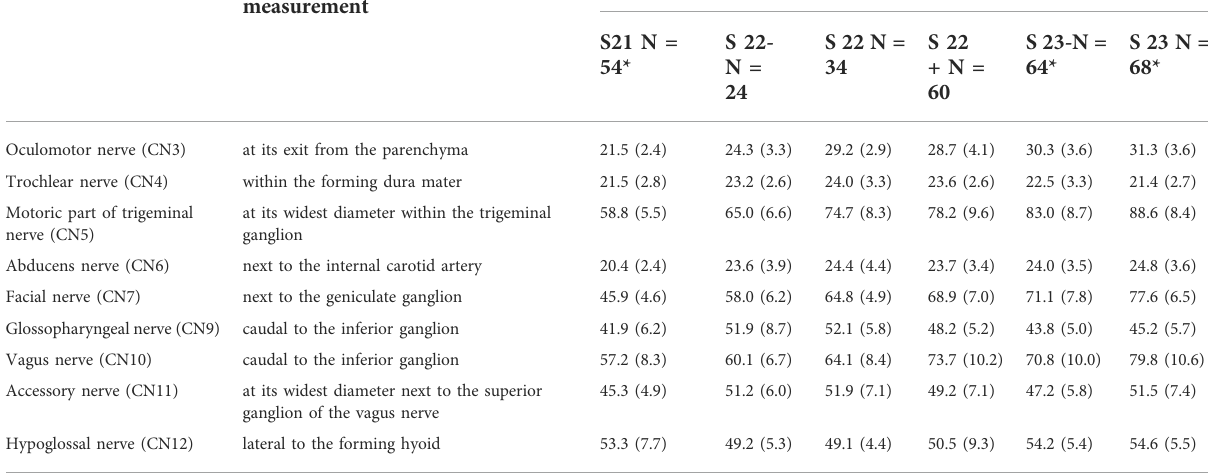
TABLE 1 Dimensions of cranial nerves at the developmental stages covered by E14.5. Data are based on a total of 152 individuals. Mean diameter and standard deviation (in parentheses) in µm. Positions of measurements are shown in Figure 4. *In four cases nerves could not be measured, which reduced the specimen number for these nerves: S21: CN12 (N = 53); S23-: CN12 (N = 63); S23: CN4 (N = 67), CN12 (N =